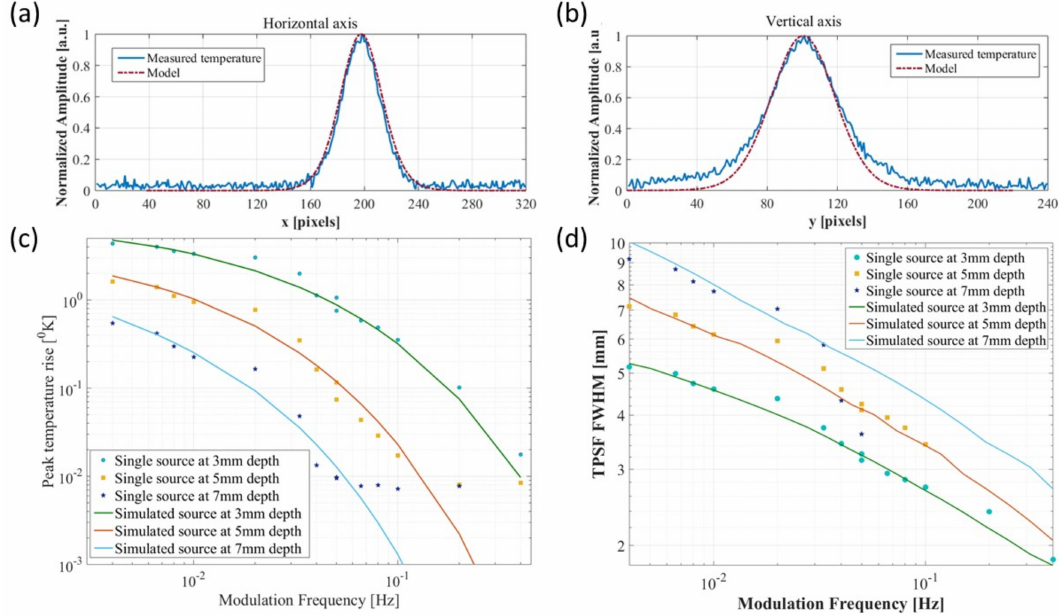
Figure 5. Comparison of the thermal model vs. measurements. ( a , b ) Comparison of the predicted PSF with measurement of a single heat source for both Horizontal and vertical axis. These show the high correlation between the theoretical and experimental results; ( c ) Peak surface temperature rise as a function of modulation frequency at different depths; ( d ) Thermal PSF FWHM as a function of modulation frequency at different depths. Those plots show the accuracy of the thermal model is retained at multiple depths and over three orders of magnitude of modulation